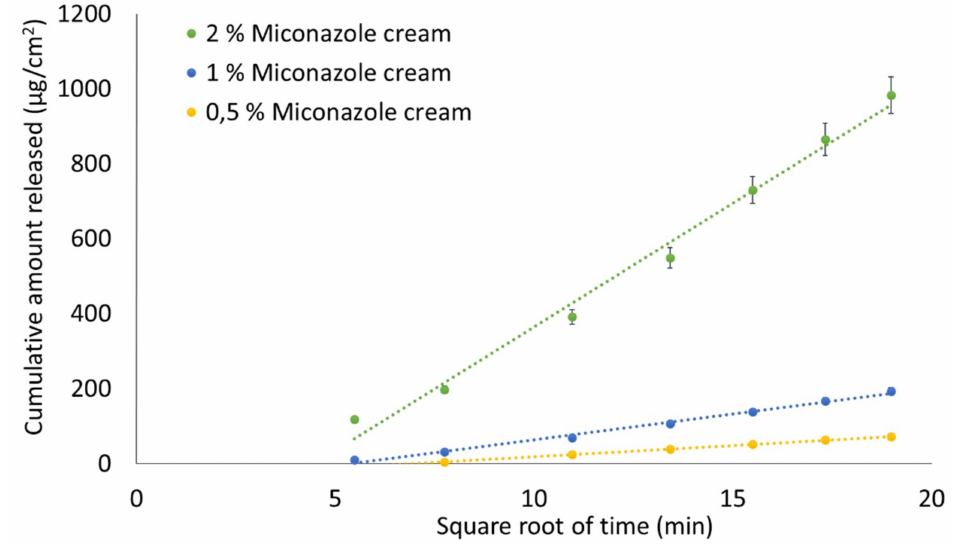
Figure 4. Release profiles of creams containing 0.5%, 1%, and 2% MCZ prepared by dilution